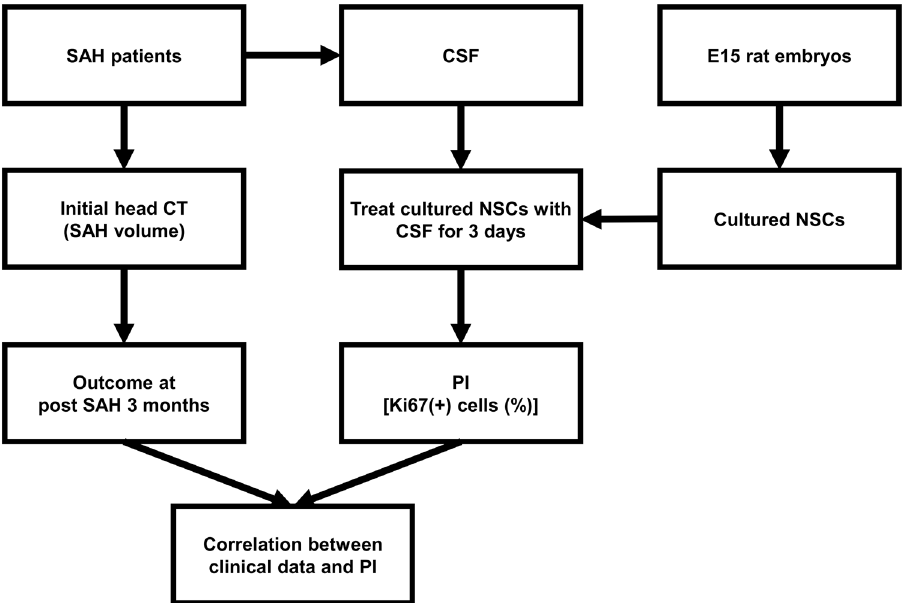
Figure 1. Study algorithm. Abbreviations: SAH, subarachnoid hemorrhage; CSF, cerebrospinal fluid; CT, computed tomography; NSC, neural stem cell; PI, proliferation index; E15, rat embryonic day